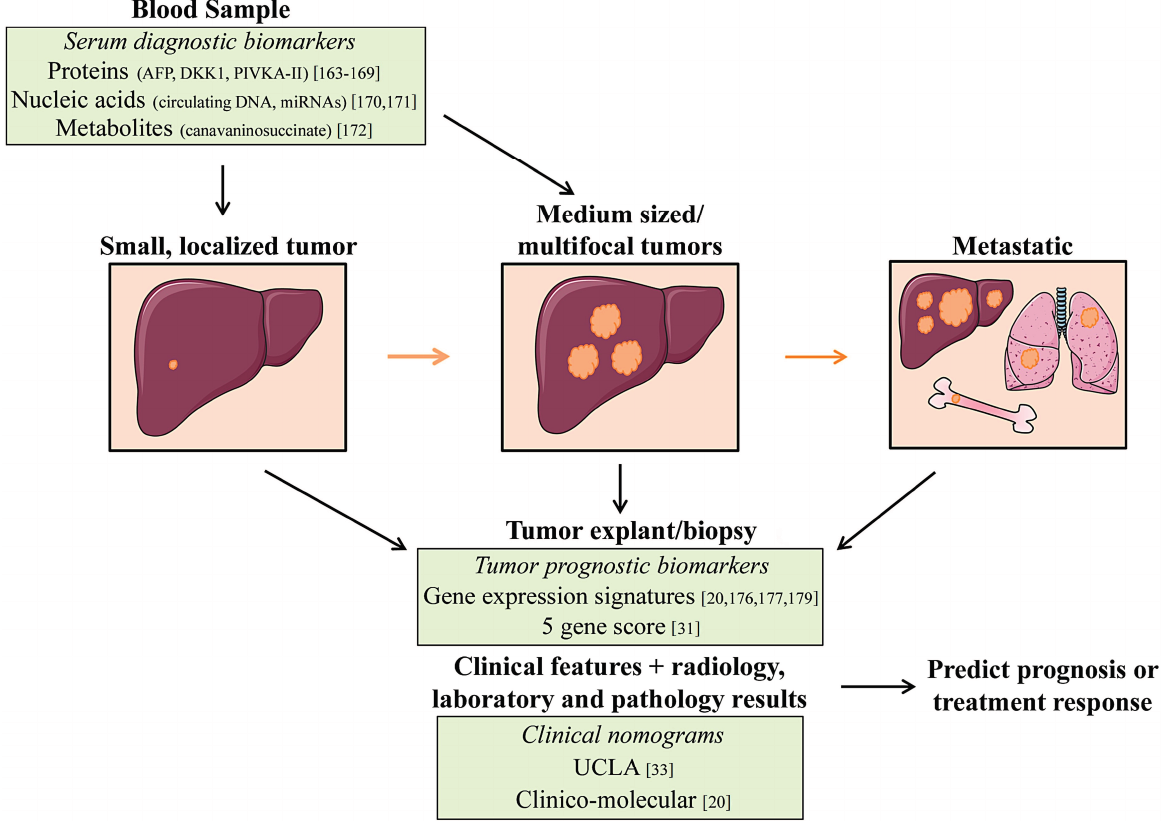
Figure 1. Proposed integration of biomarkers into HCC treatment. ( Left ) Few patients present with HCC tumors amenable to curative therapies, so emphasis has been placed on biomarkers to detect early-stage HCCs. Proteins, nucleic acids, and metabolites released by the tumor into circulation can provide a non-invasive method of early detection. ( Middle, Right ) Most treatment decisions for HCC patients are currently based on tumor size and liver